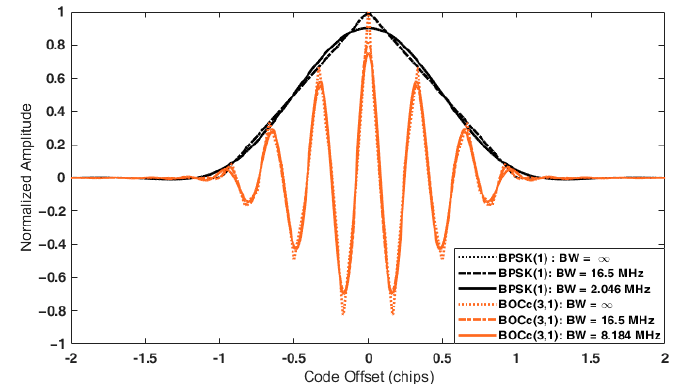
Figure 7. Autocorrelation function of BPSK(1) and BOC c (3,1).